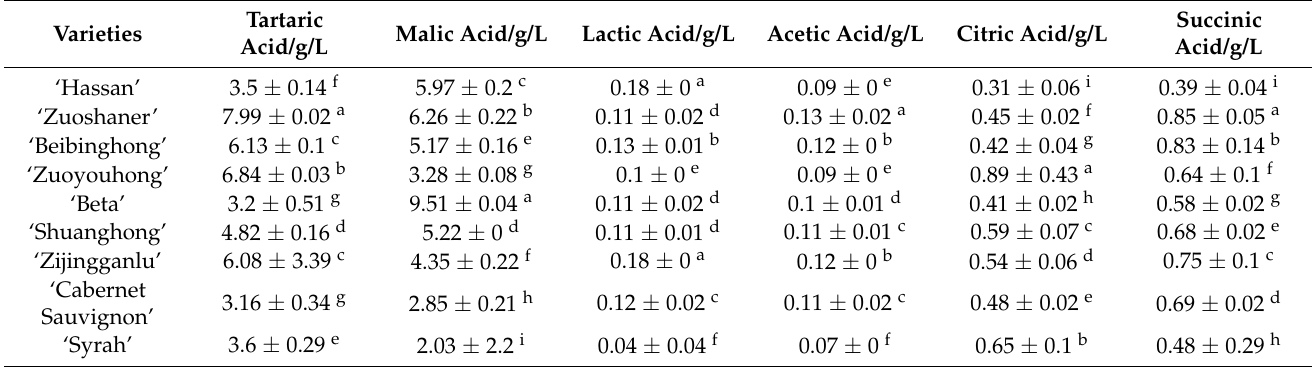
Table 5. Comparison of Organic Acids in Different Variety Wine